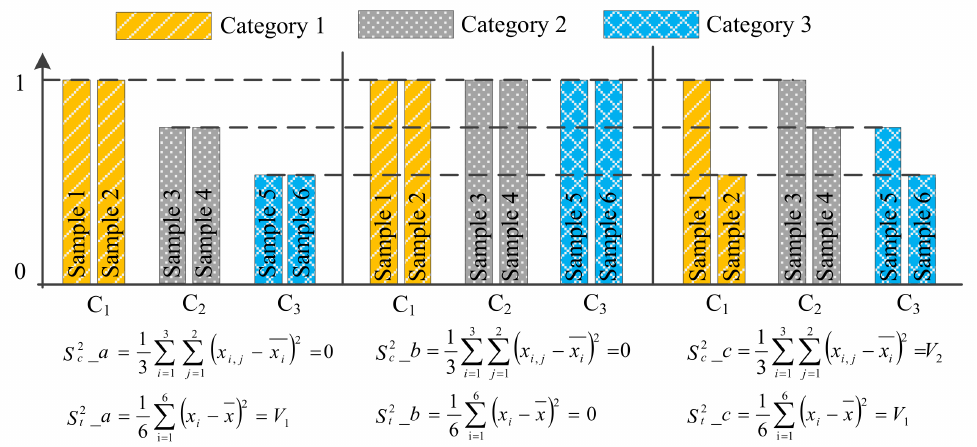
Figure 7. Three distribution states of the same feature for six